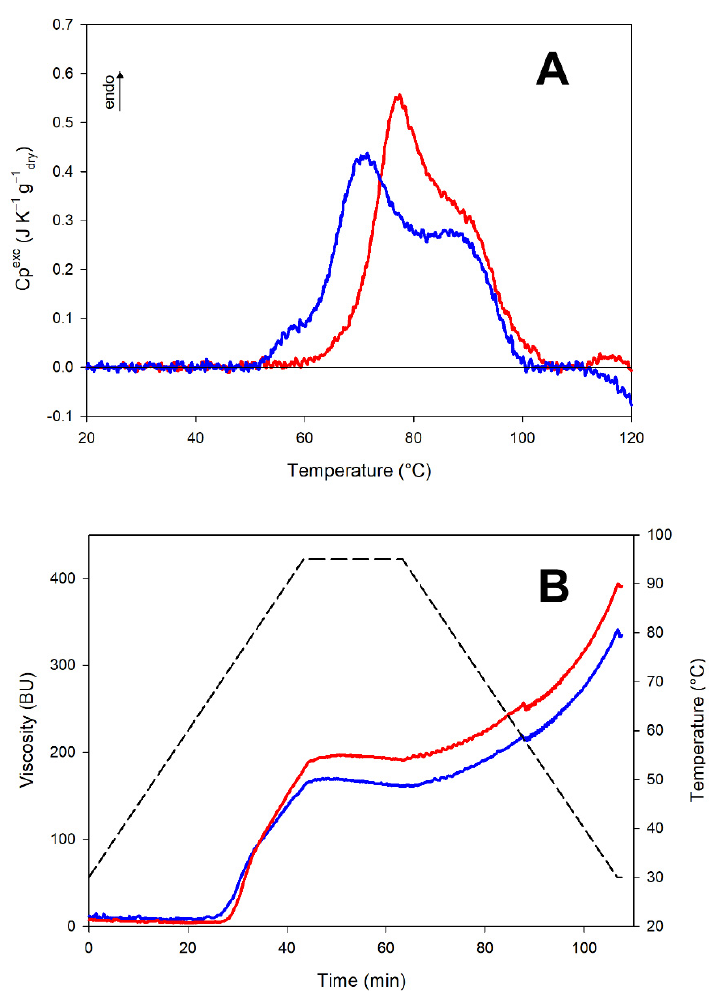
Figure 1. Starch properties. Raw flour (blue line) and heat-treated flour (red line) from red lentils. Panel ( A ): Differential scanning calorimetry (DSC) traces recorded at 60% moisture content. Panel ( B ): Micro Visco-Amylo-Graph traces.